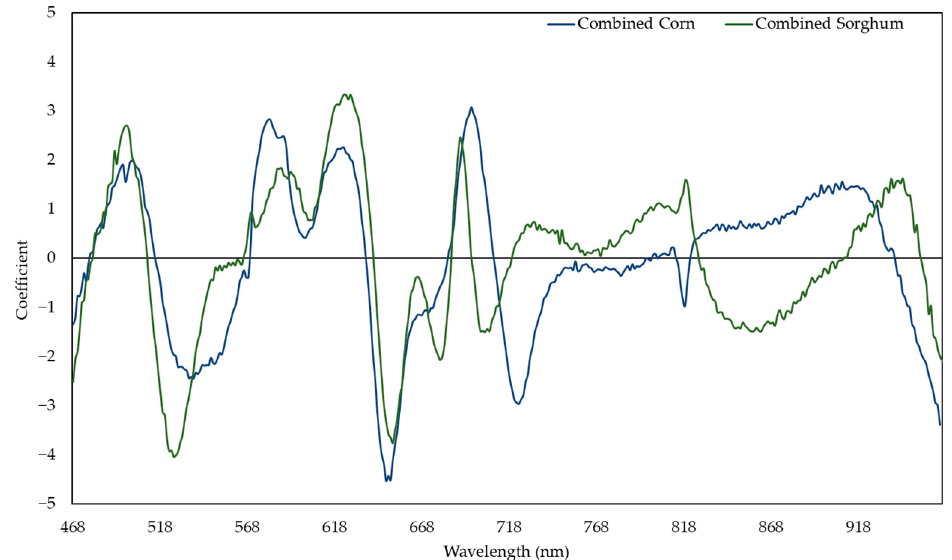
Figure 4. Coefficients in models predicting the relative water content with the responses of com-